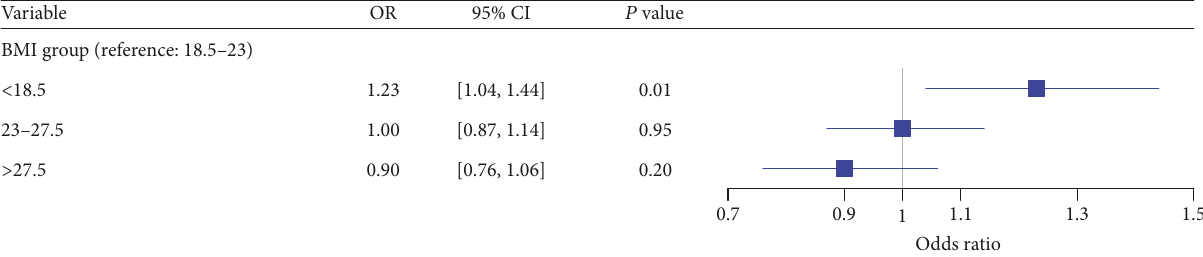
Figure 3: Multivariate logistic regression models for studying the relationship between BMI and acute kidney injury in hospitalised patients (total number of patients = 12,555; patients with acute kidney injury = 1606; patients with no acute kidney injury = 10,949). Note . BMI: body massindex;CI:confidenceinterval;OR:oddsratio.Adjustedvariablesinlogisticregressionmodelsincludeage,gender,ethnicity,background diagnoses (cardiovascular disease, chronic kidney disease, diabetes mellitus, hepatobiliary disease, psychiatric illness, and gastrointestinal disease), primary diagnoses (infectious and parasitic diseases, neoplasm, diseases of the genitourinary system, diseases of the musculoskeletal system and connective tissue, and symptoms, signs, and ill-defined conditions), and procedures (otolaryngology related surgery, endoscopy, open laparotomy, and cardiology related percutaneous